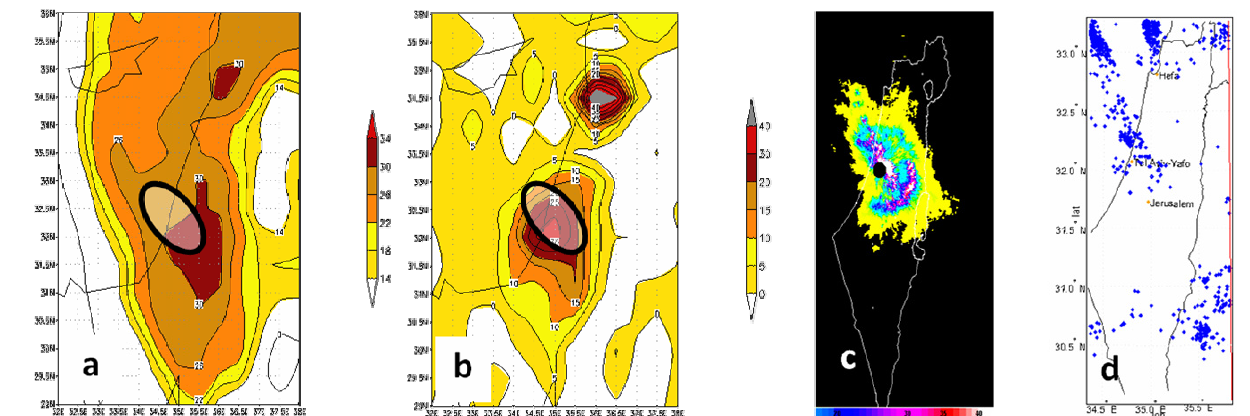
Fig. 3. Spatial distribution of (a) MKI, (b) RDI, both for 2 April, 00:00UTC, (c) uncalibrated rain totals derived from the radar reflectivity over the period 1 April 2006, 23:00UTC–2 April 2006, 01:00UTC and (d) distribution of cloud-to-ground flashes observed by LPATS for 1 April, 00:00UTC–2 April, 00:00UTC, representing the 1st phase of the Wadi-Ara event. The bold ellipses in (a) and (b) represent the core of the rain system.